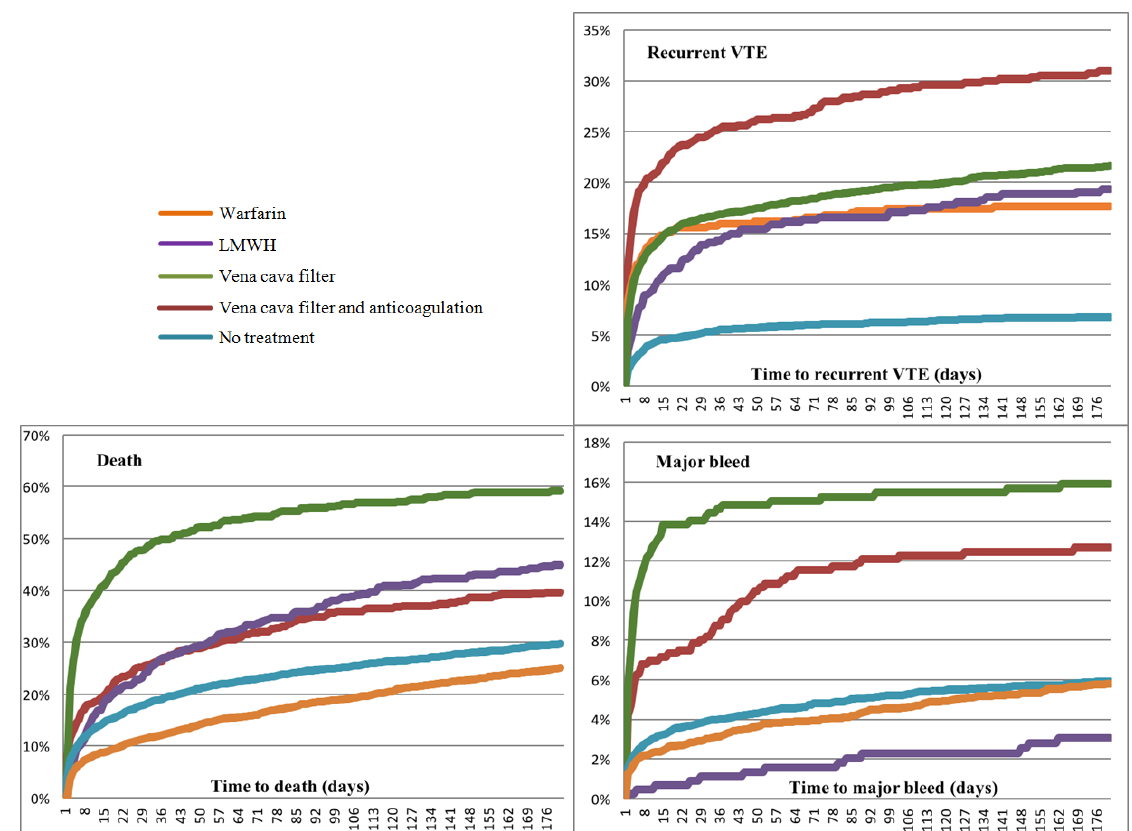
Figure 1. Cumulative Incidence Functions of Outcome Events - Competing risks time-to-event analysis by treatment group over 180 days of follow-up. Cumulative incidence is the percent of the cohort experiencing each event. Cumulative incidence is unweighted and no demographic or clinical characteristics are controlled